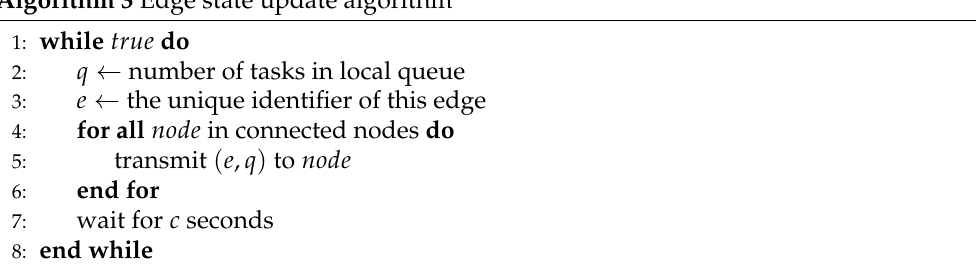
Algorithm 3 Edge state update